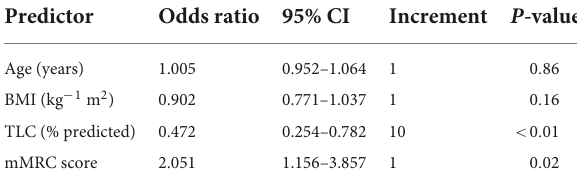
TABLE 5 Results of the logistic regression